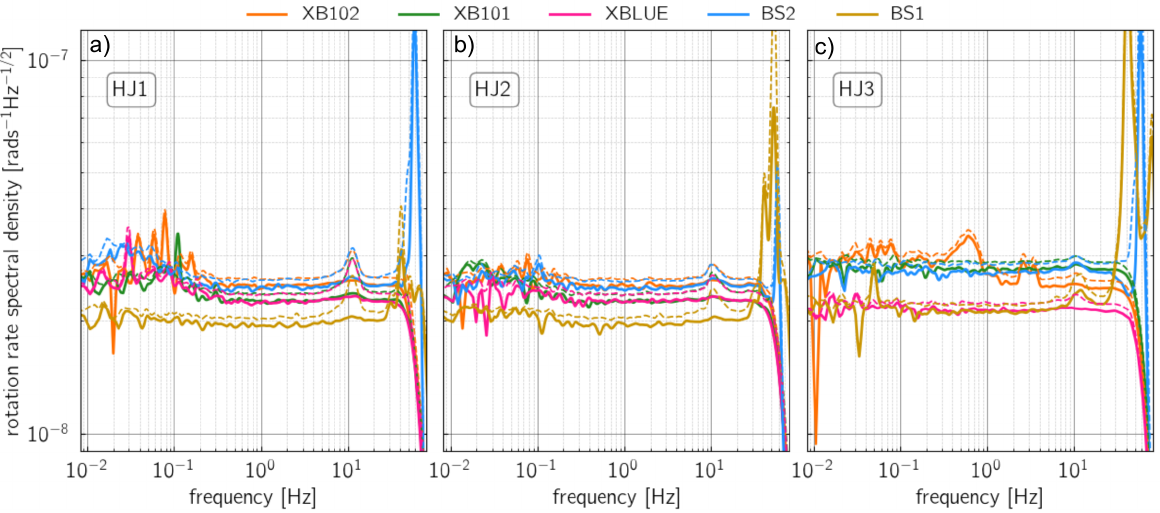
Figure 4. Self-noise power spectral densities (PSD) of XB102 (Orange), XB101 (Green), XBLUE (Pink), BS1 (Yellow) and BS2 (Blue) for the East ( a ), North ( b ) and vertical components ( c ). The dashed line represents the simple single sensor PSD. The solid lines show the results from the 3-station method after Sleeman et al.